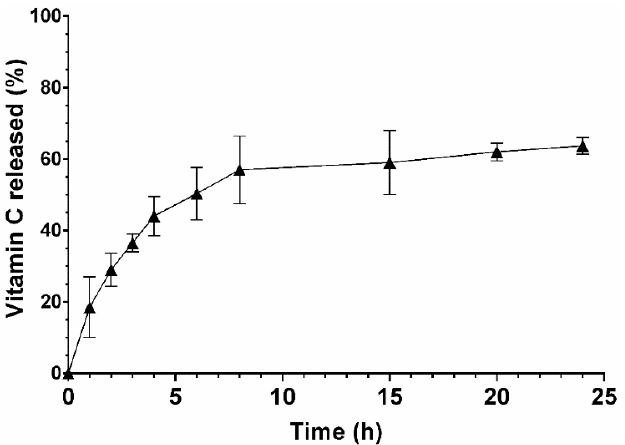
Figure 4. Characterization of the release profile of Vitamin C from nanoparticles at pH 7. Black triangle represents the percentage of Vitamin C released at different timepoints. Data are presented as mean ± SEM ( n = 3).